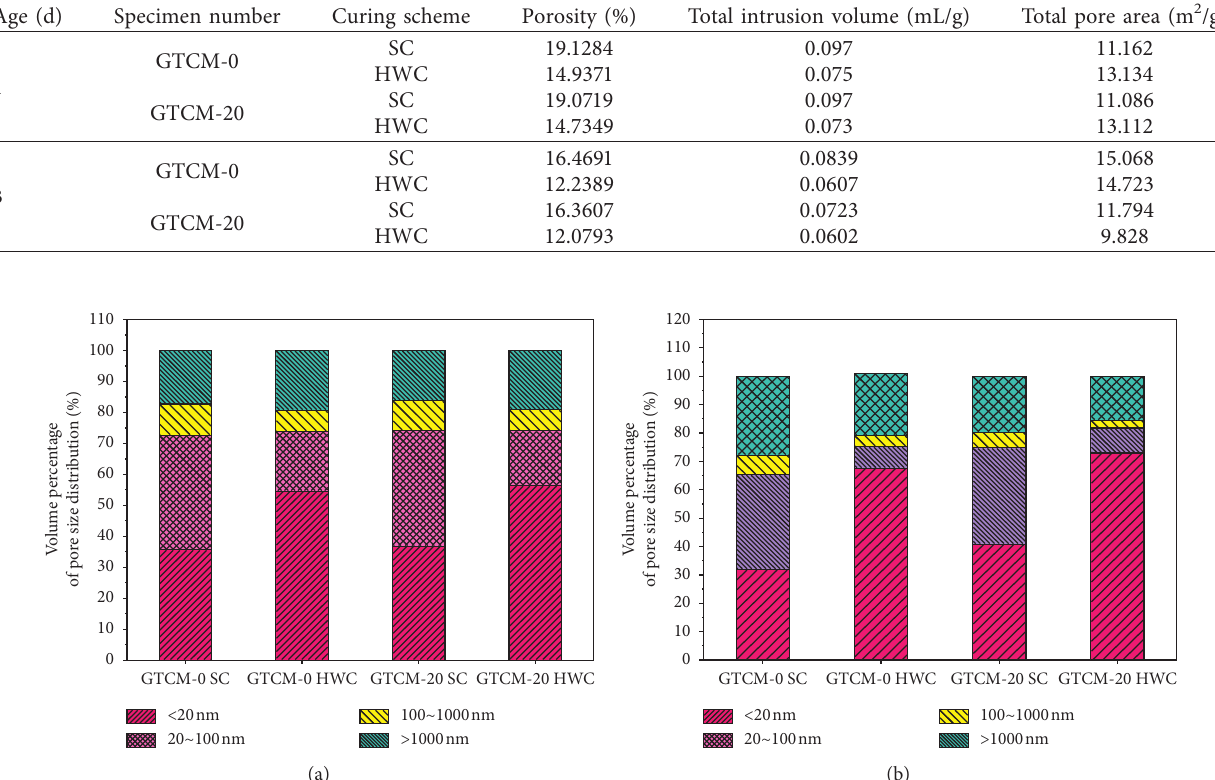
Table 7: Porosity, total pore size, and area of GTCM-0 and GTCM-20 under SC and HWC methods.